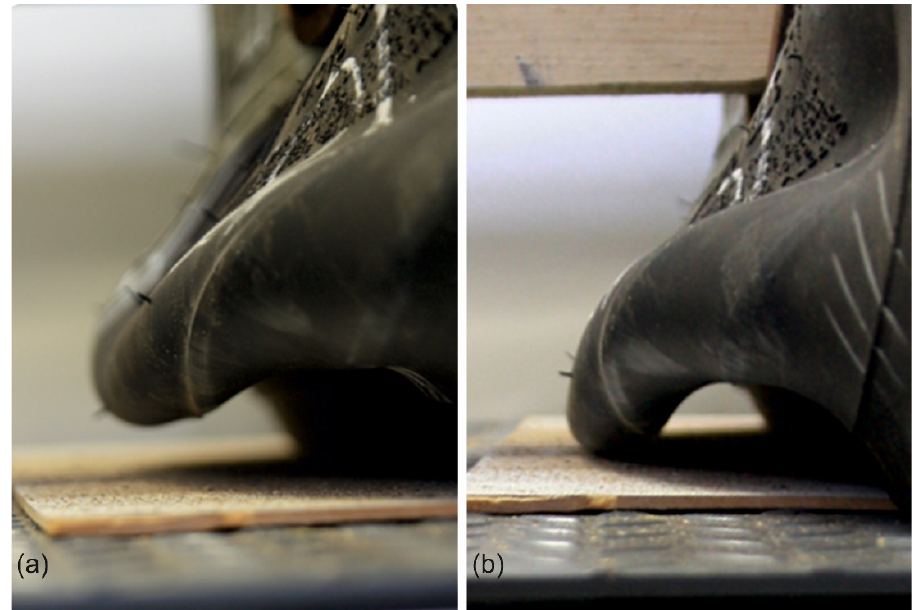
Figure 16. Profile deformation under a load of ( a ) 603 kg; ( b ) 676 kg.